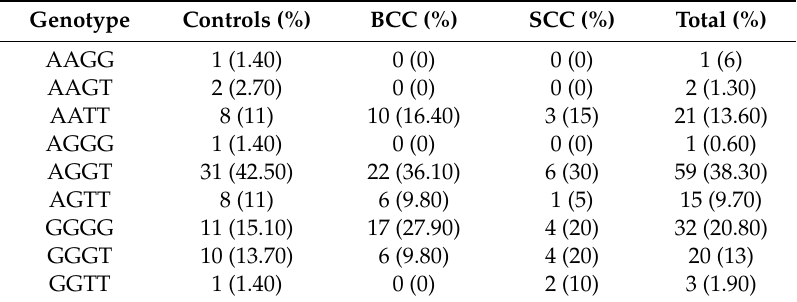
Table 5. The combined BsmI / ApaI genotypes in BCCs, SCCs and controls.